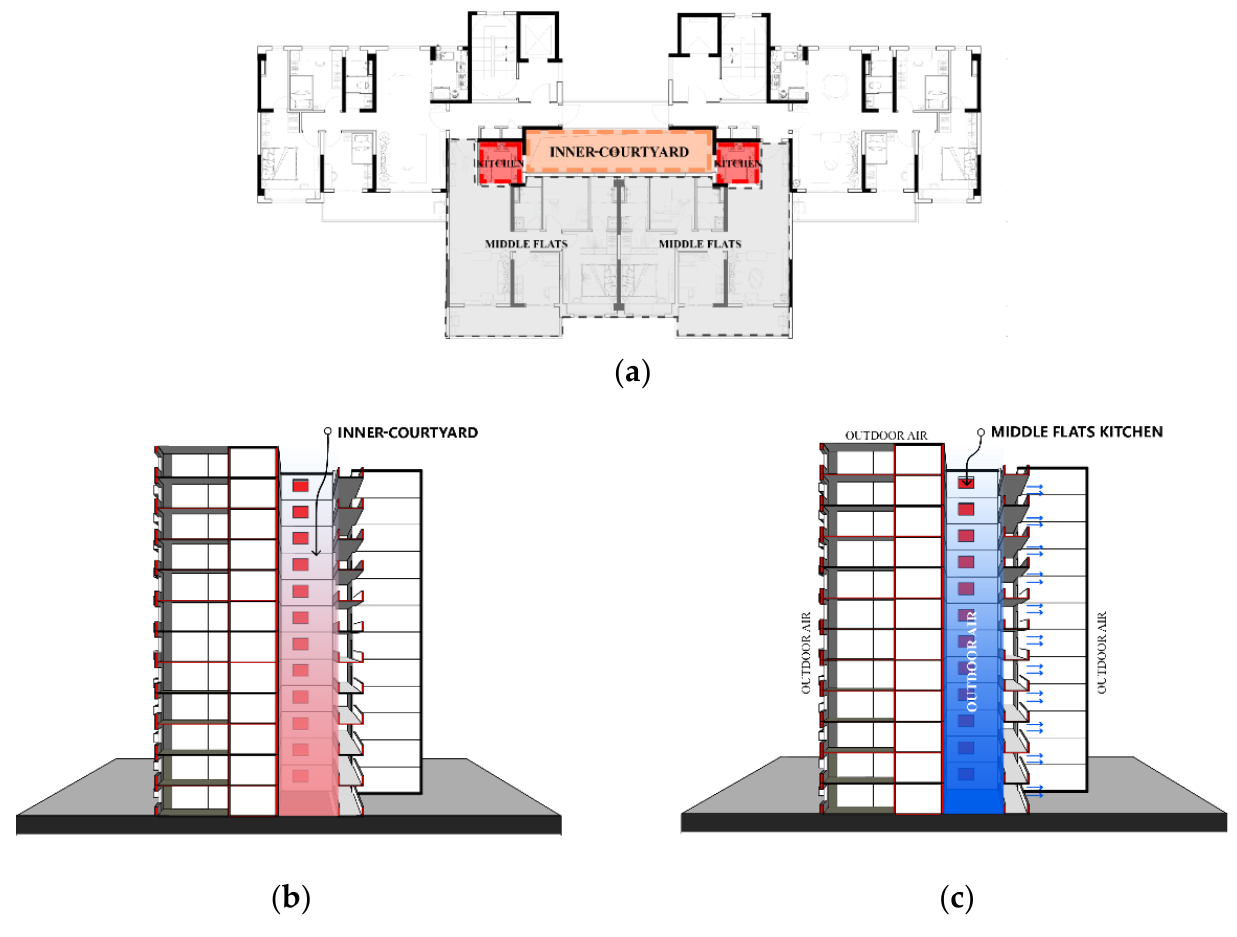
Figure 1. One kind of high-rise residence with multiple flats sharing one staircase (containing an inner-courtyard): ( a ) plan view; ( b ) section of the inner-courtyard layout; ( c ) airflow simulation in the inner-courtyard.